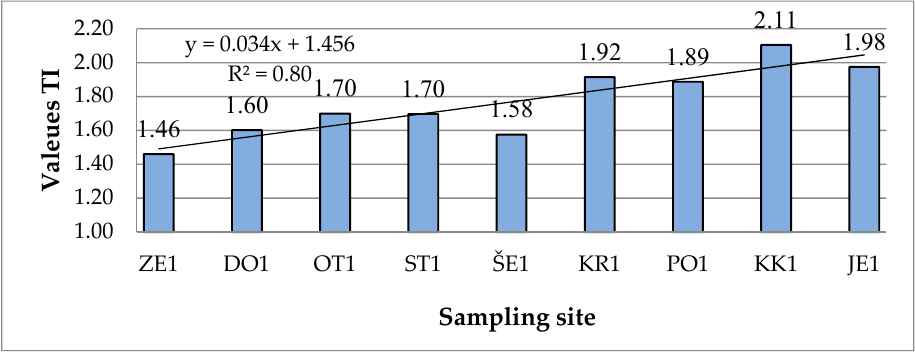
Figure 6. Trophic index values for all winter samples (Sampling sites are defined in Figure 1).